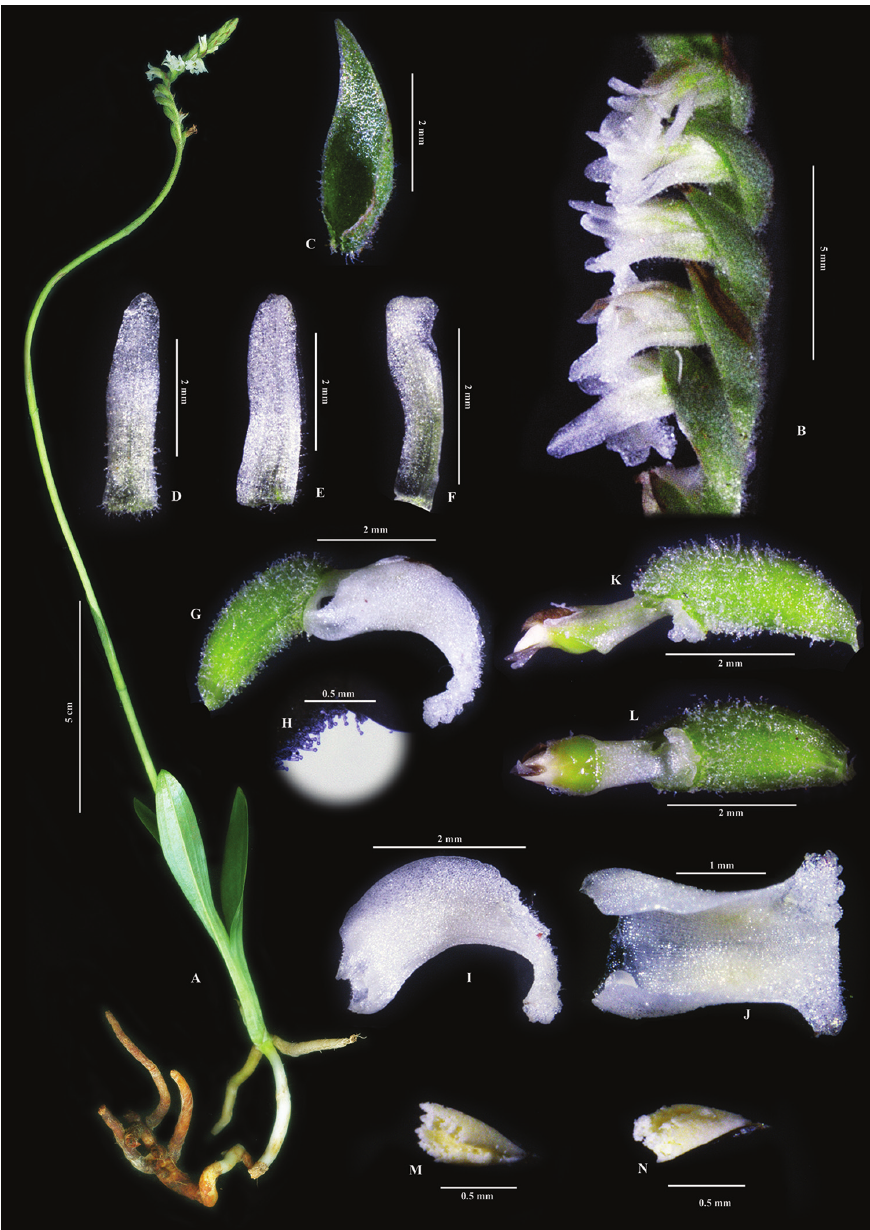
Figure 3. Spiranthes himalayensis Survesw., Kumar & Mei Sun, sp. nov. A Complete plant B Inflores- cence C Floral bract D Dorsal sepal E Lateral sepal F Petal G Ovary with column and labellum H Close- up showing the glandular hairs on flower and ovary I Side view of labellum J Top view of labellum K Side view of ovary with column L Front view of ovary and column M Front view of pollinarium N Side view of pollinarium. Note: The pinkish/bluish hue on petals of S. himalayensis is due to the black background in the plates while the flowers appear fully white in natural